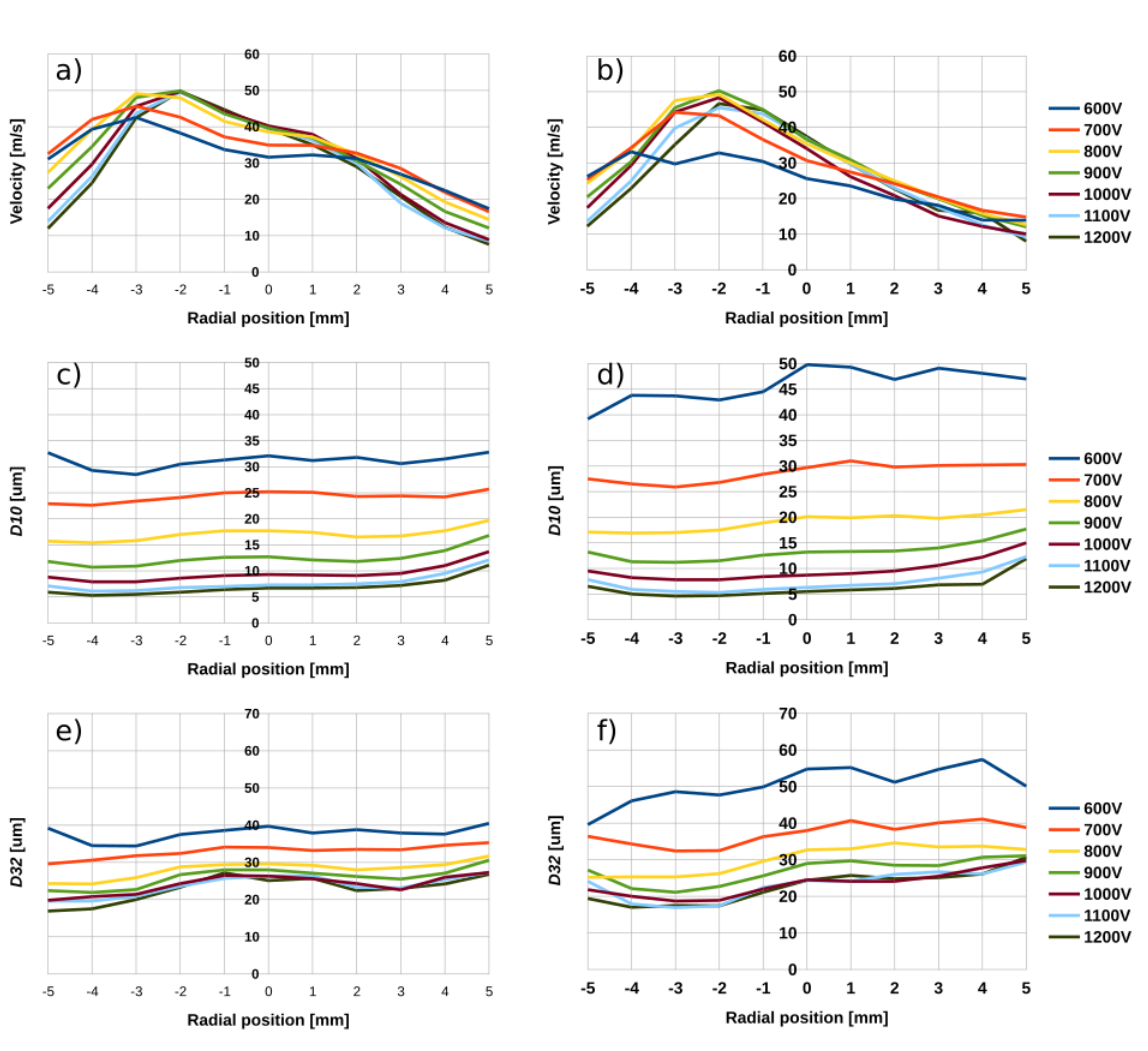
Fig. 4 . Effect of the photomultiplier sensitivity: a), b) radial profiles of mean axial velocity in the axial distance of 10 mm from the nozzle, c), d) radial profiles of D10 and e), f) radial profiles of D32 . Left column a), c), e): system A. Right column b), d), f): system